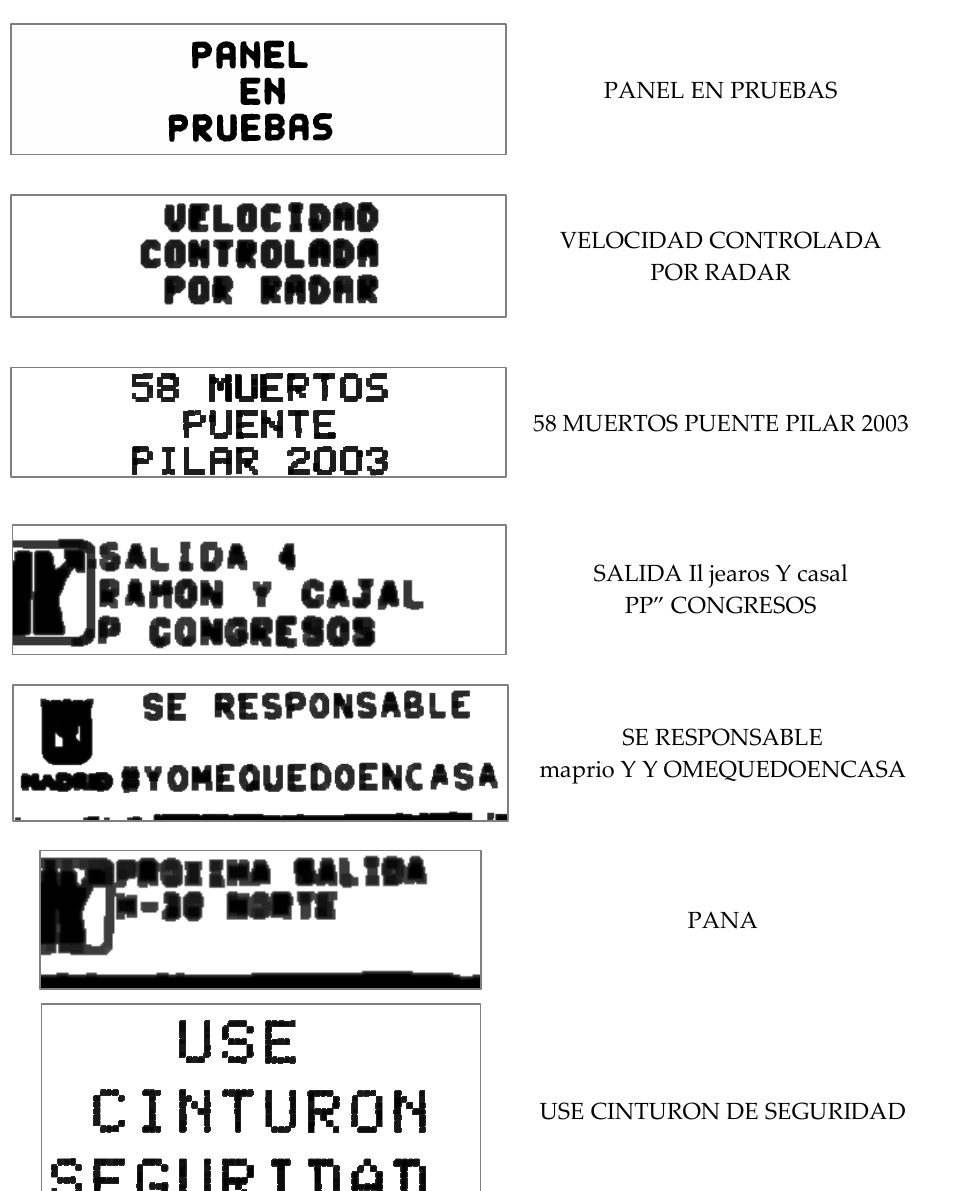
Figure 6. Image preprocessing examples.